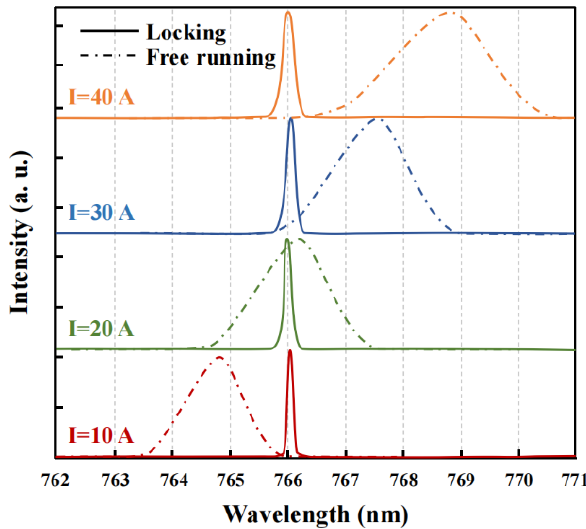
Figure 4. Spectral characteristics of the free-running and locking three CS lasers based on spatial beam combination at four different operating currents.